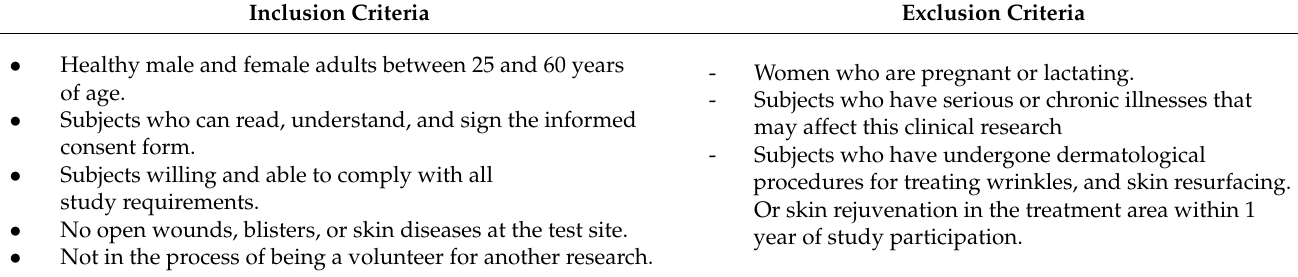
Table 2. Inclusion and exclusion